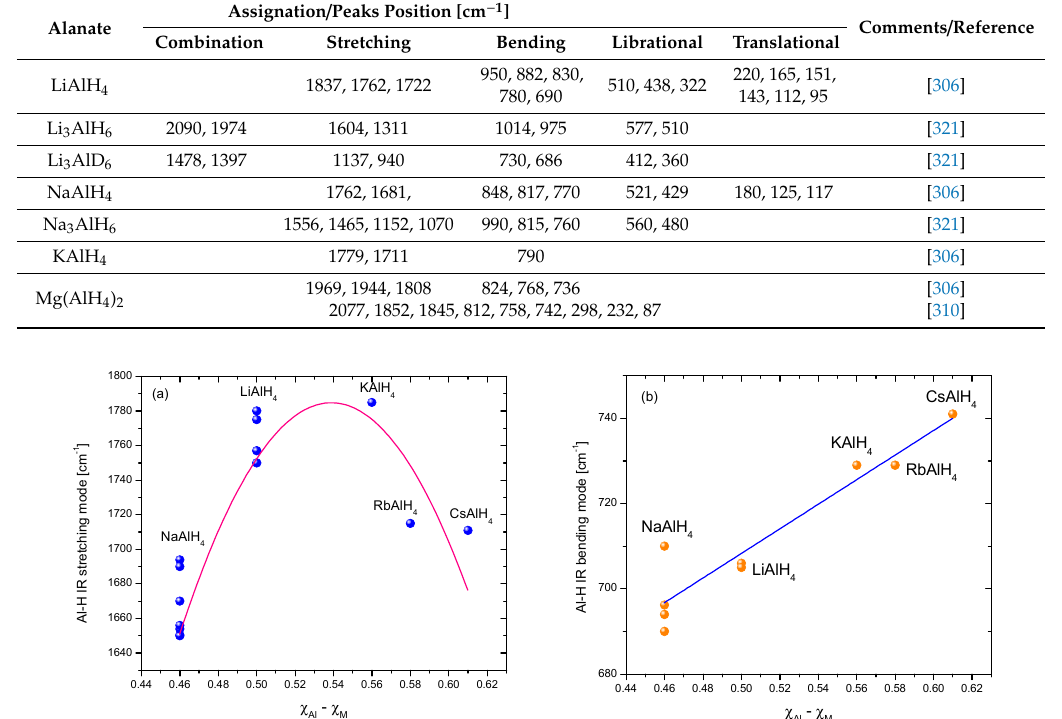
Table 20. Representative Raman frequencies of Al-H bonds reported for di ff erent alanates.